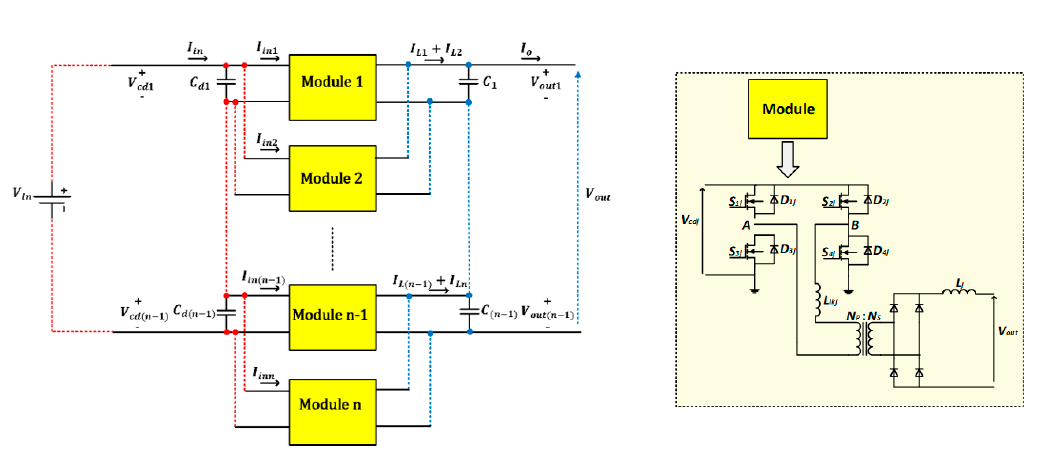
Figure 8. 𝐧 module Input-Series Input-Parallel Output-Series Output-Parallel (ISIP-OSOP) DC-DC converter SSM. Since the input current and voltage per module are (cid:3010) (cid:3284)(cid:3289) 𝛂 and (cid:3023) (cid:3284)(cid:3289) 𝛃 , respectively, and the output current and voltage per module is (cid:3010) (cid:3290) 𝒂 and (cid:3023) (cid:3290) 𝒃 , respectively. Therefore, the load resistance per module is 𝒂 𝒃 𝑅 . Accordingly, 𝑑(cid:4632) (cid:3036)(cid:3037) and 𝑑(cid:4632) (cid:3049)(cid:2920) , which are the effect of changing the filter inductor current and the